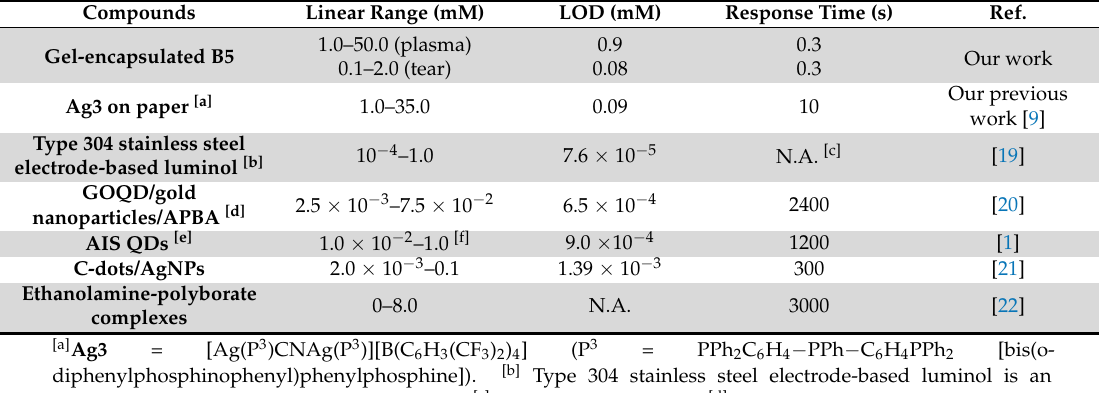
Table 1. Comparison of the analytical performance of proposed glucose detection method with those of some luminescence glucose